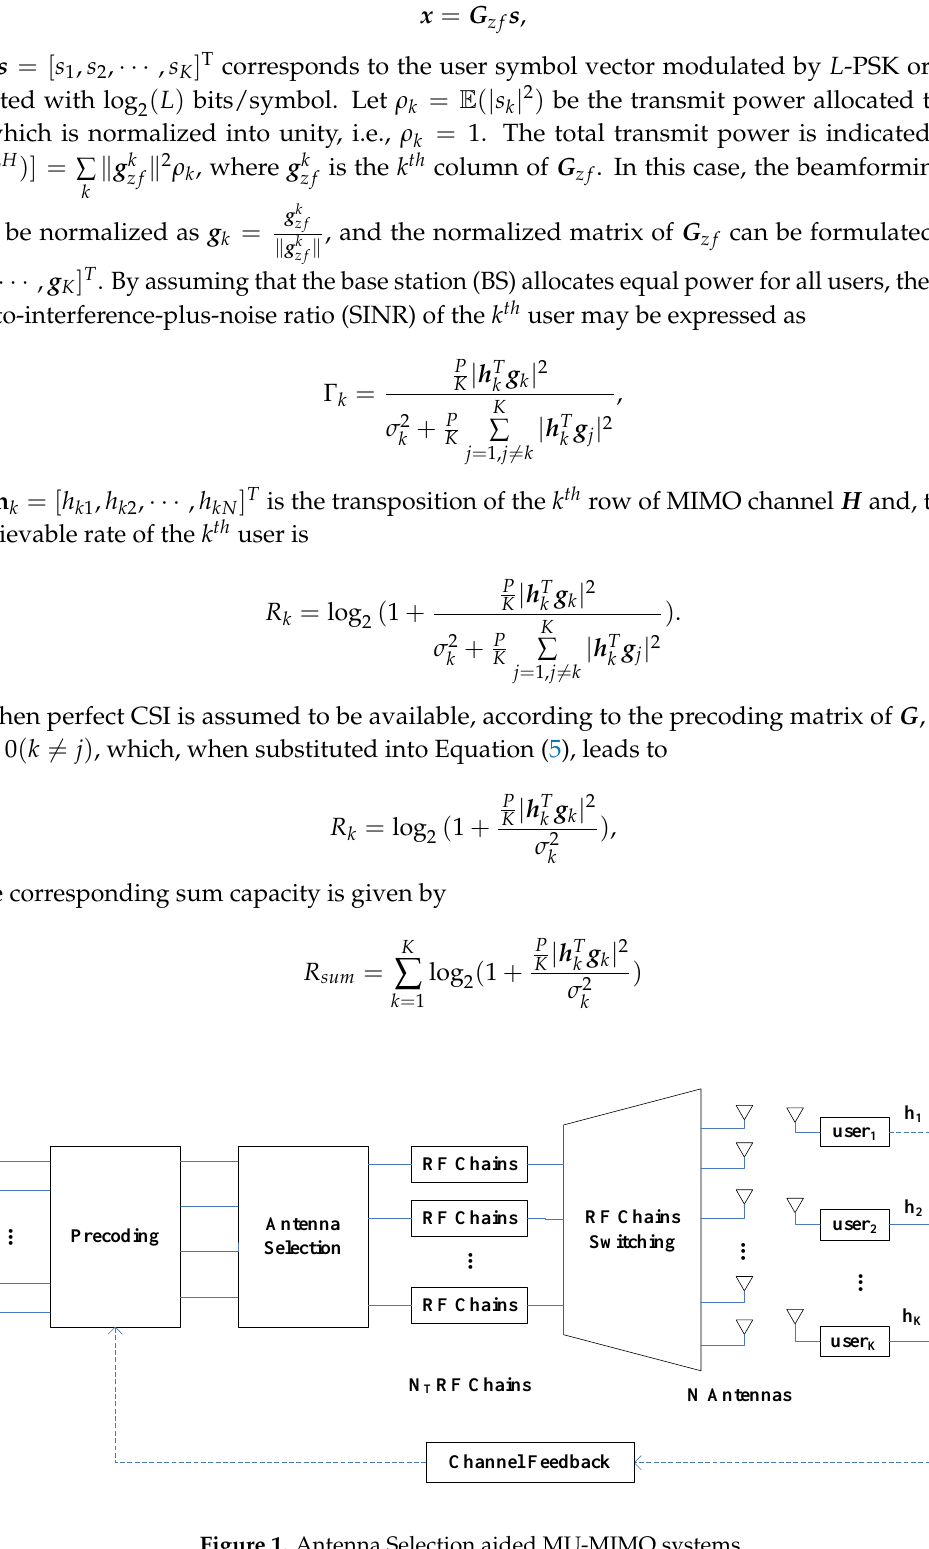
Figure 1. Antenna Selection aided MU-MIMO